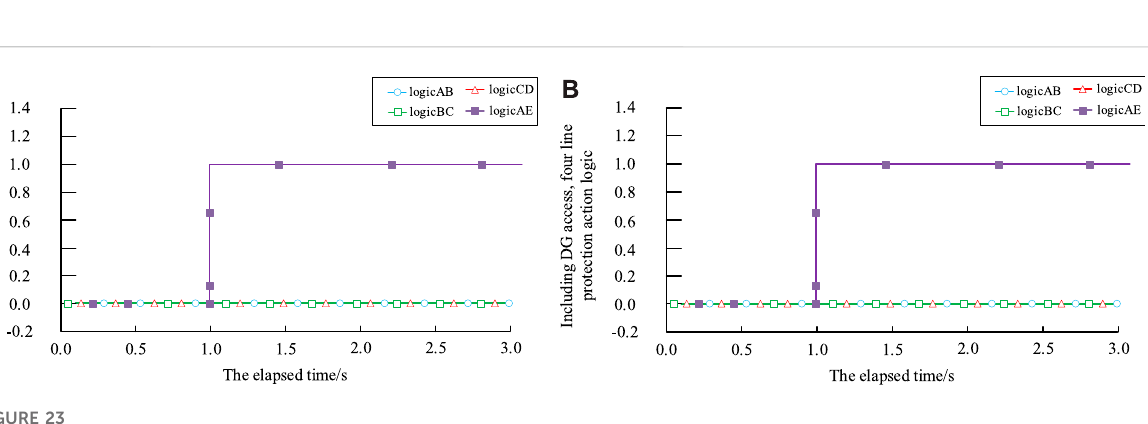
FIGURE 23 Three-stage protection action logic when AE terminal three-phase short circuit fault occurs. (A) Simulation results before DG access (B) simulation results after DG